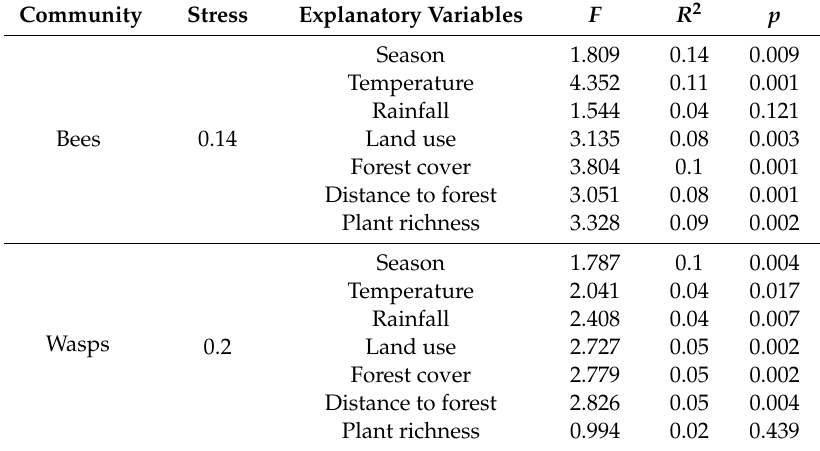
Table 3. Environmental e ff ects on composition of bee and wasp communities. Bee communities were influenced by all environmental factors except rainfall. Wasp communities were influenced by all environmental factors except plant richness. Parameters reported are from permutational mANOVAs and non-metrical multidimensional scaling (NMDS) based on Bray–Curtis similarity distances between abundance of each species per trap nest unit, per season (999 permutations, 3